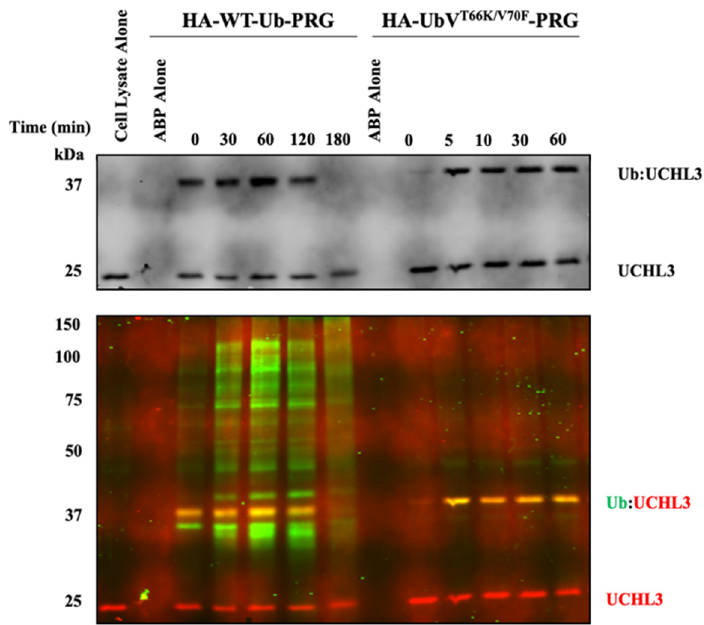
Figure 1. Time-dependent Western blot for Ub-ABPs. HA-WT-Ub-PRG and HA-UbV T66K/V70F -PRG, 5 µM, were both dosed into HEK293 lysates (0.5 mg/mL). Samples were tested at the indicated time points. ( Top ) Western blot for UCHL3 indicating the free-UCHL3 and Ub-UCHL3 complex gel shifted. ( Bottom ) Western blot for HA (green fluorescence) and UCHL3 (red fluorescence).